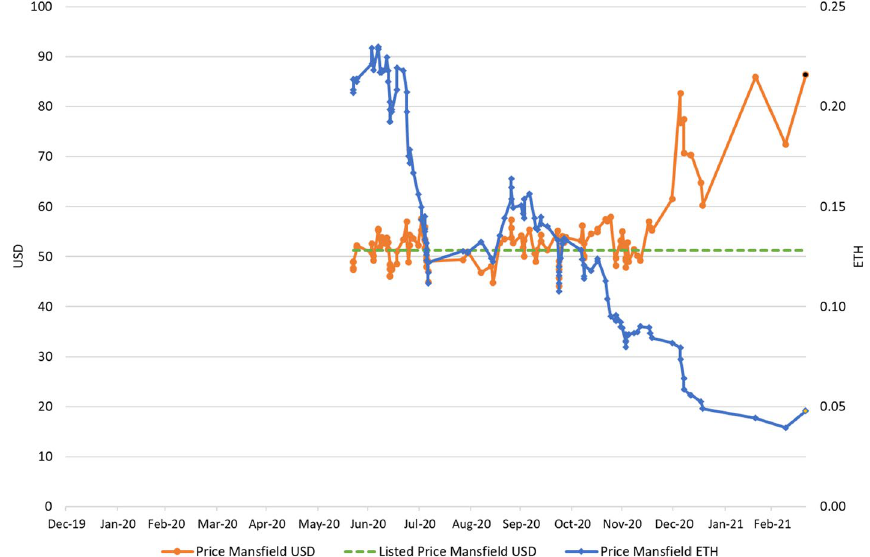
Fig. 19 Price (in USD and ETH) of 18,900 Mansfield Street Detroit MI. Each dot represents one transaction. Last colored dot is ask price on